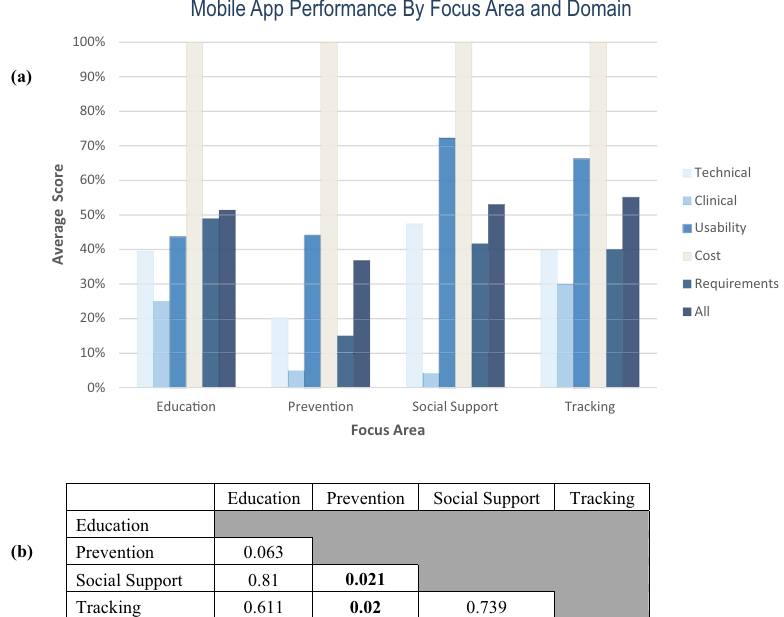
Fig. 3 Mobile app performance by focus area and domain. a Mobile app performance by focus area and domain areas. Mean scores across technical, clinical, usability, cost, and end-user requirement domains are represented in bar graphs. b Statistical comparison among focus areas.